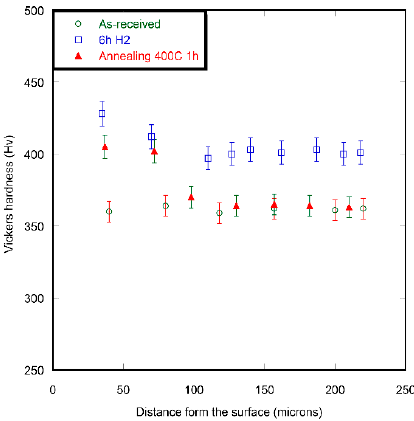
Figure 10. Linear pattern Vickers hardness from the surface to the center of as-received, immersed and aged, and annealed specimens after hydrogen diffusion.